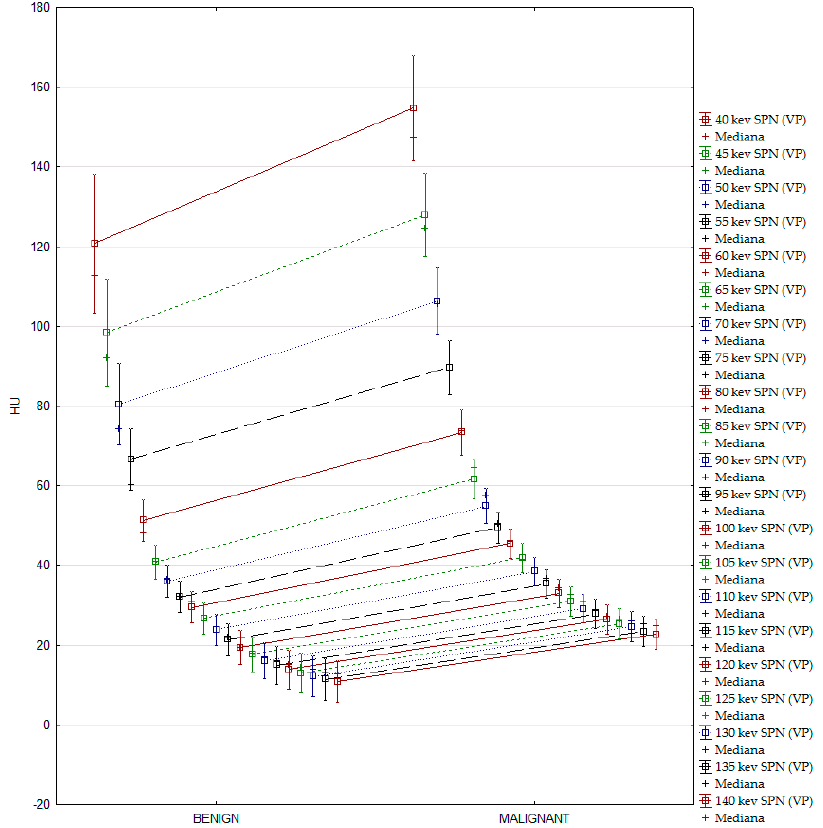
Figure A2. Distribution of the mean values of absorbed radiation measured on monochromatic images (VP) in benign and malignant nodules. TableA1. Analysisofdifferencesbetweenmalignantandbenignnodules. Student’s t andMann–Whitney U * analyses. Thresholds, sensitivity, specificity, and AUCs are based on the ROC curves for each keV energy level in